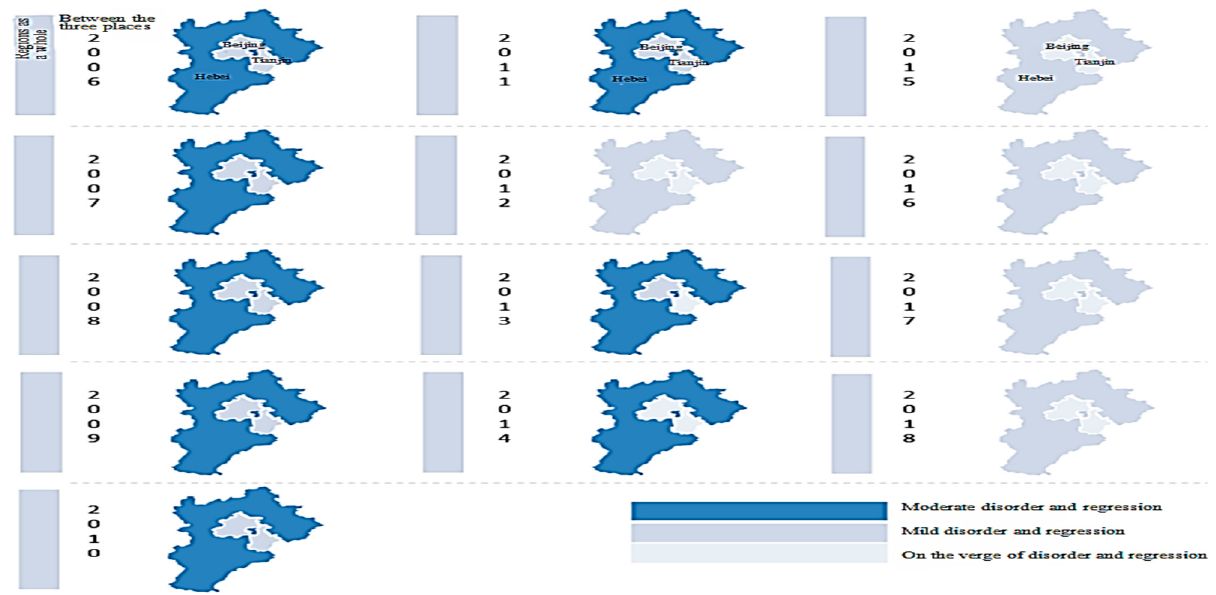
Figure 3. Evolution of coordinated development types of economy–ecology—high haze pollution in the Beijing–Tianjin–Hebei region.